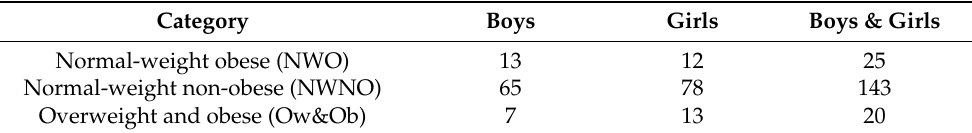
Table 2. Frequency distribution of children from n = 188 in each defined category.